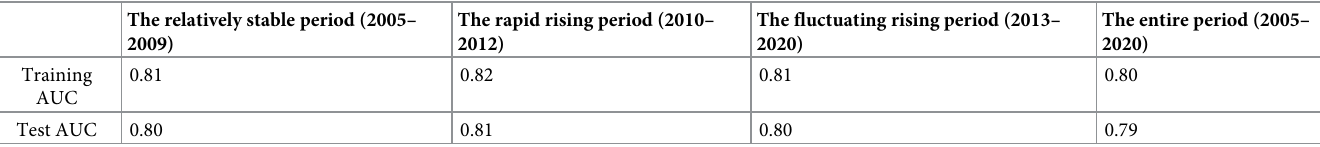
Table 2. The fitting results of four MaxEnt models.